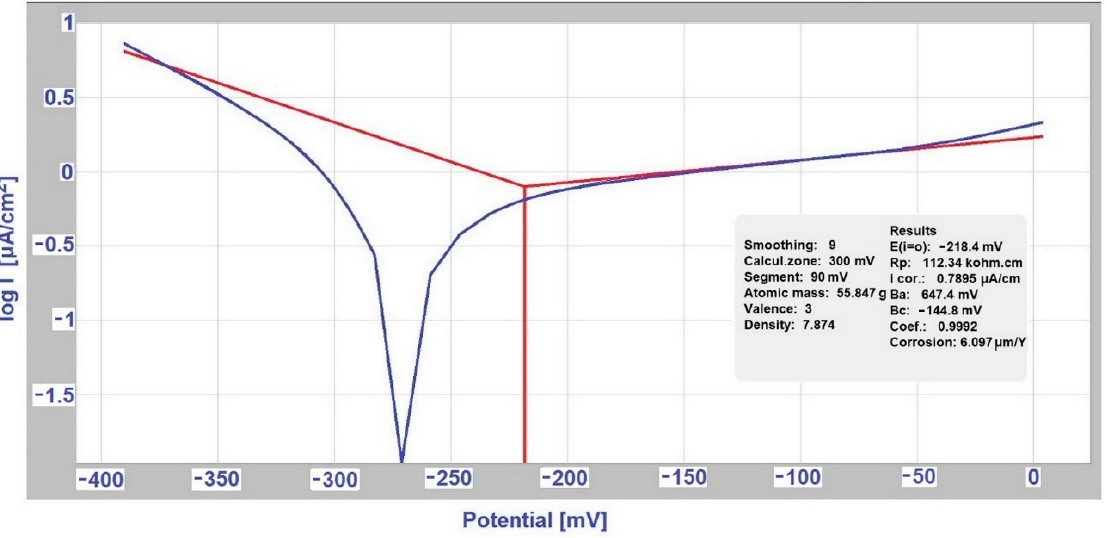
Figure 5. Measurement according to Tafel for stainless steel (hot-dip galvanized steel/EN AW-6060 couple) in the first week (deicing salt).